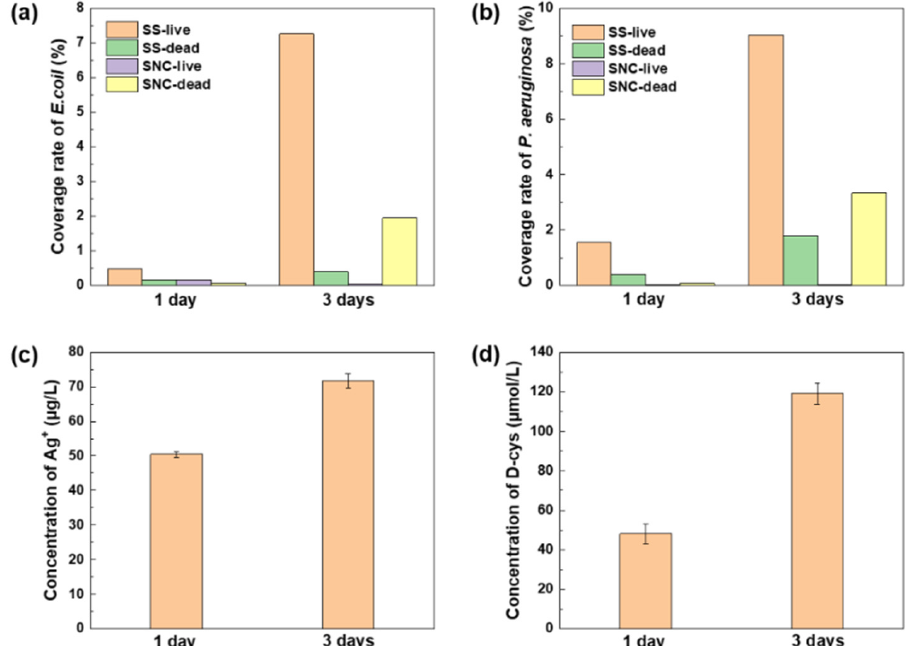
Figure 10. The coverage rates of ( a ) E. coli and ( b ) P. aeruginosa on the SS and SNC surfaces after 1 day and 3 days of immersion in the inoculated media; the concentrations of released ( c ) Ag + and ( d ) D-cys from the SNC surface after 1 day and 3 days of immersion in the LB medium. The adhesion conditions of E. coli and P. aeruginosa cells on the sample surfaces